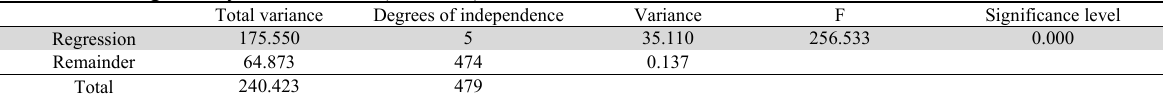
Results of testing - Analysis of variance (ANOVA) Total variance Degrees of independence 479